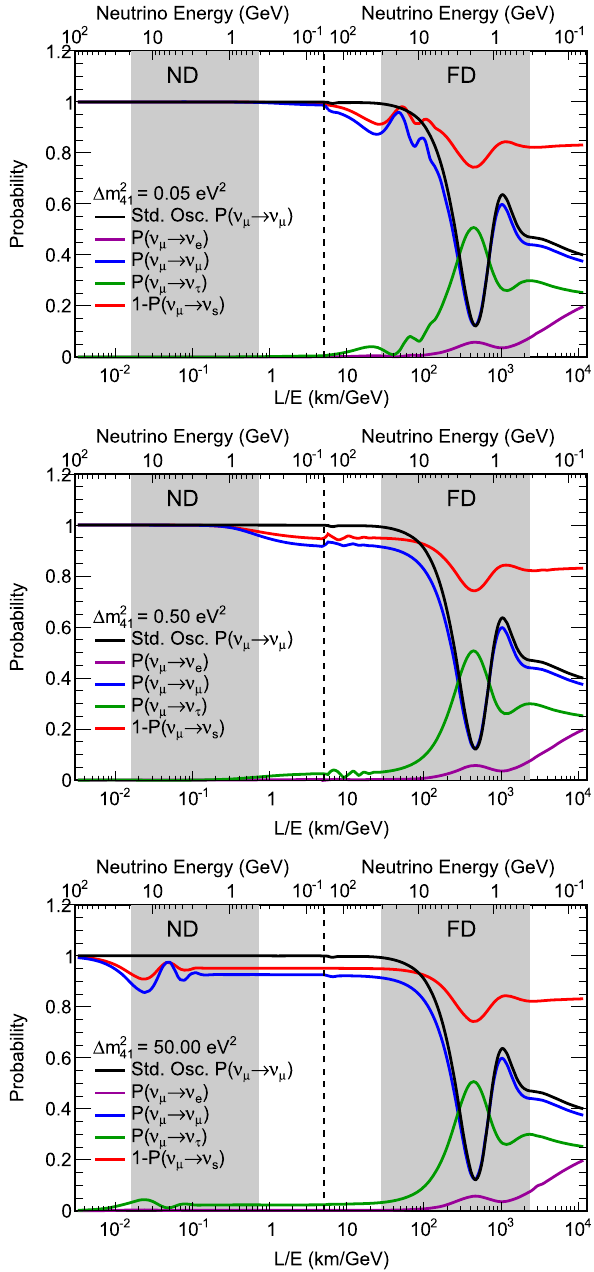
Fig. 1 Regions of L / E probed by the DUNE detector compared to 3-flavor and 3 + 1-flavor neutrino disappearance and appearance proba- bilities. The gray-shaded areas show the range of true neutrino ener- gies probed by the ND and FD. The top axis shows true neutrino energy, increasing from right to left. The top plot shows the probabili- = 0 . 05eV 2 , ties assuming mixing with one sterile neutrino with Δ m 2 41 corresponding to the slow oscillations regime. The middle plot assumes = 0 . 5eV 2 , corresponding mixing with one sterile neutrino with Δ m 2 41 to the intermediate oscillations regime. The bottom plot includes mix- = 50eV 2 , corresponding to ing with one sterile neutrino with Δ m 2 41 the rapid oscillations regime. As an example, the slow sterile oscilla- tions cause visible distortions in the three-flavor ν μ survival probability (bluecurve)forneutrinoenergies ∼ 10GeV,wellabovethethree-flavor oscillation